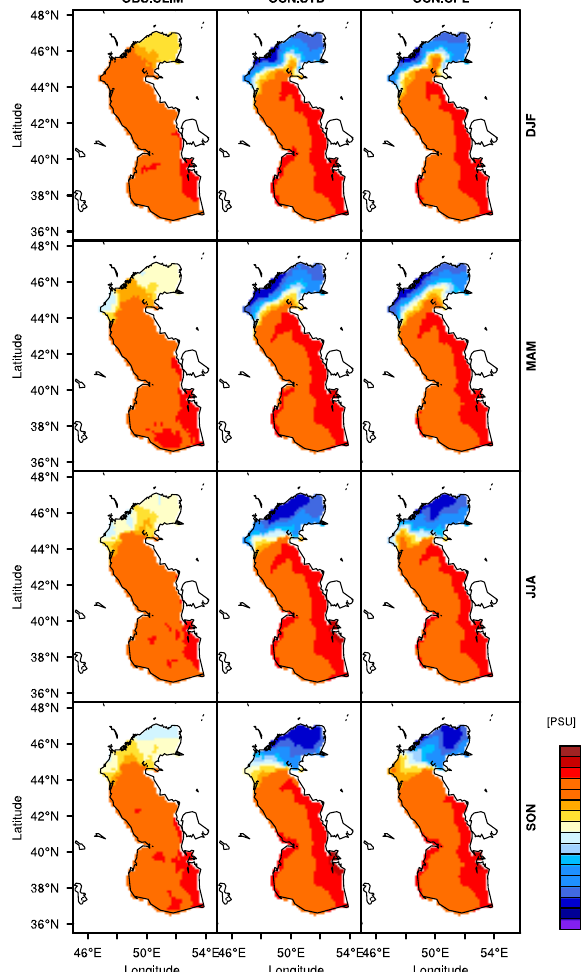
Fig. 11. Seasonal sea surface salinity (SSS) climatology of simula- tions (OCN.STD and OCN.CPL) and observation (from Ibrayev et al., 2001) for the period 1999–2008.